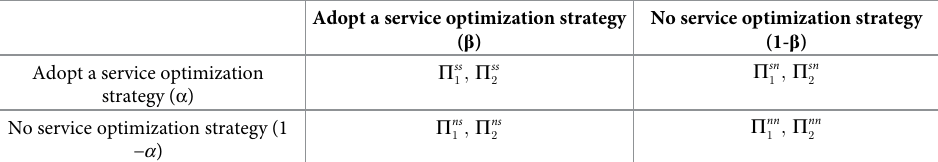
Table 2. Payment matrix of evolution game between freight train and shipping. Adopt a service optimization strategy ( β